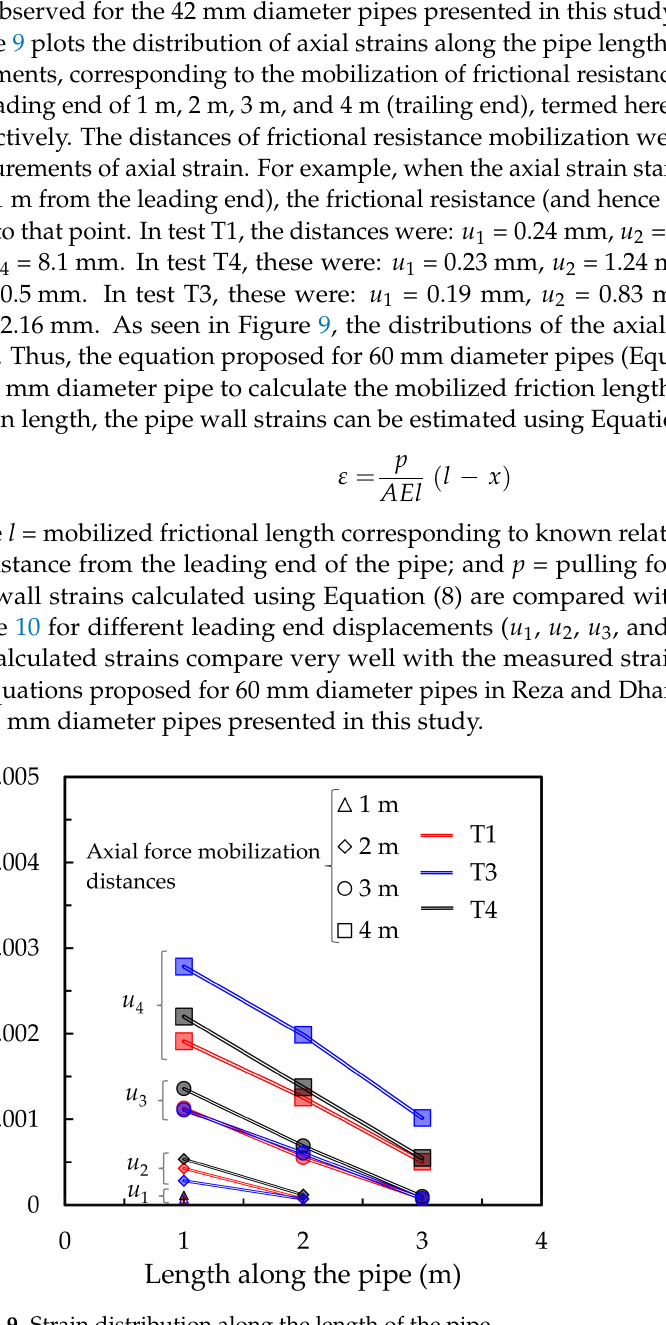
Figure 9. Strain distribution along the length of the